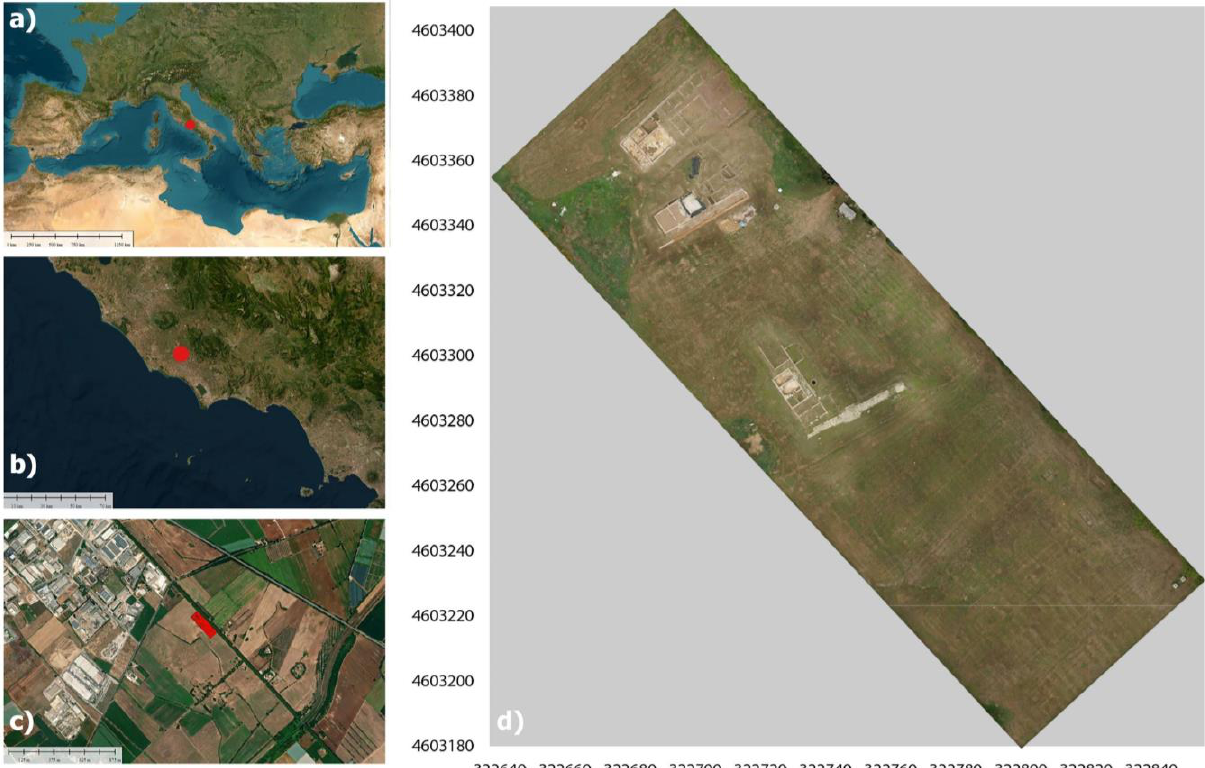
Figure 2. Test area: ( a , b ) location map; ( c ) the area of the “Tres Tabernae” (Italy); ( d ) UAV orthophoto of the visible archaeological remains.